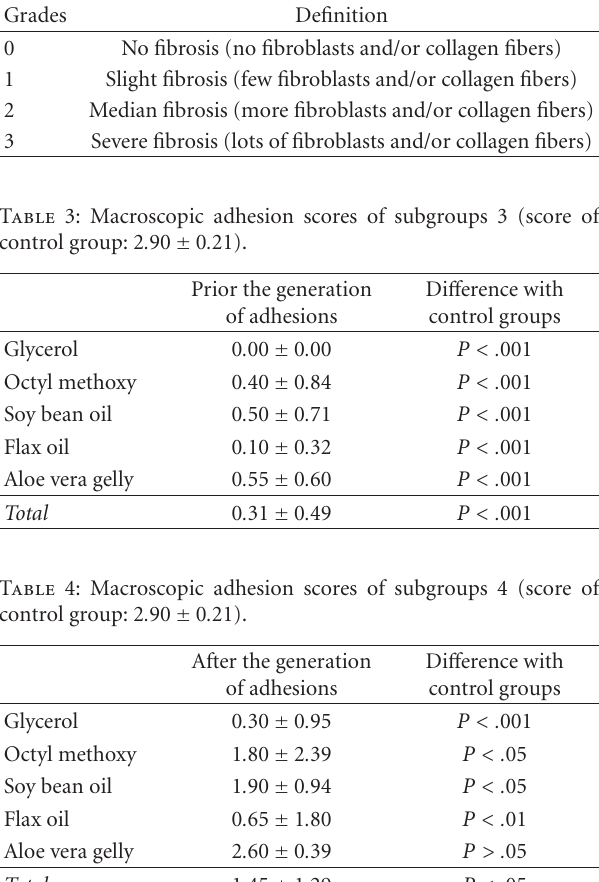
Table 5: Microscopic adhesion values of subgroups 3 (value of control group: 2 . 80 ± 0 . 42).